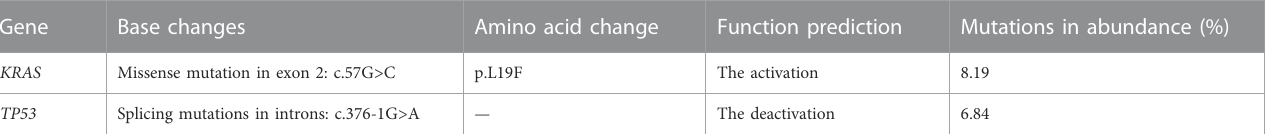
TABLE 1 Gene mutations associated with tumor targeted therapy. Base changes Amino acid change Function prediction Mutations in abundance